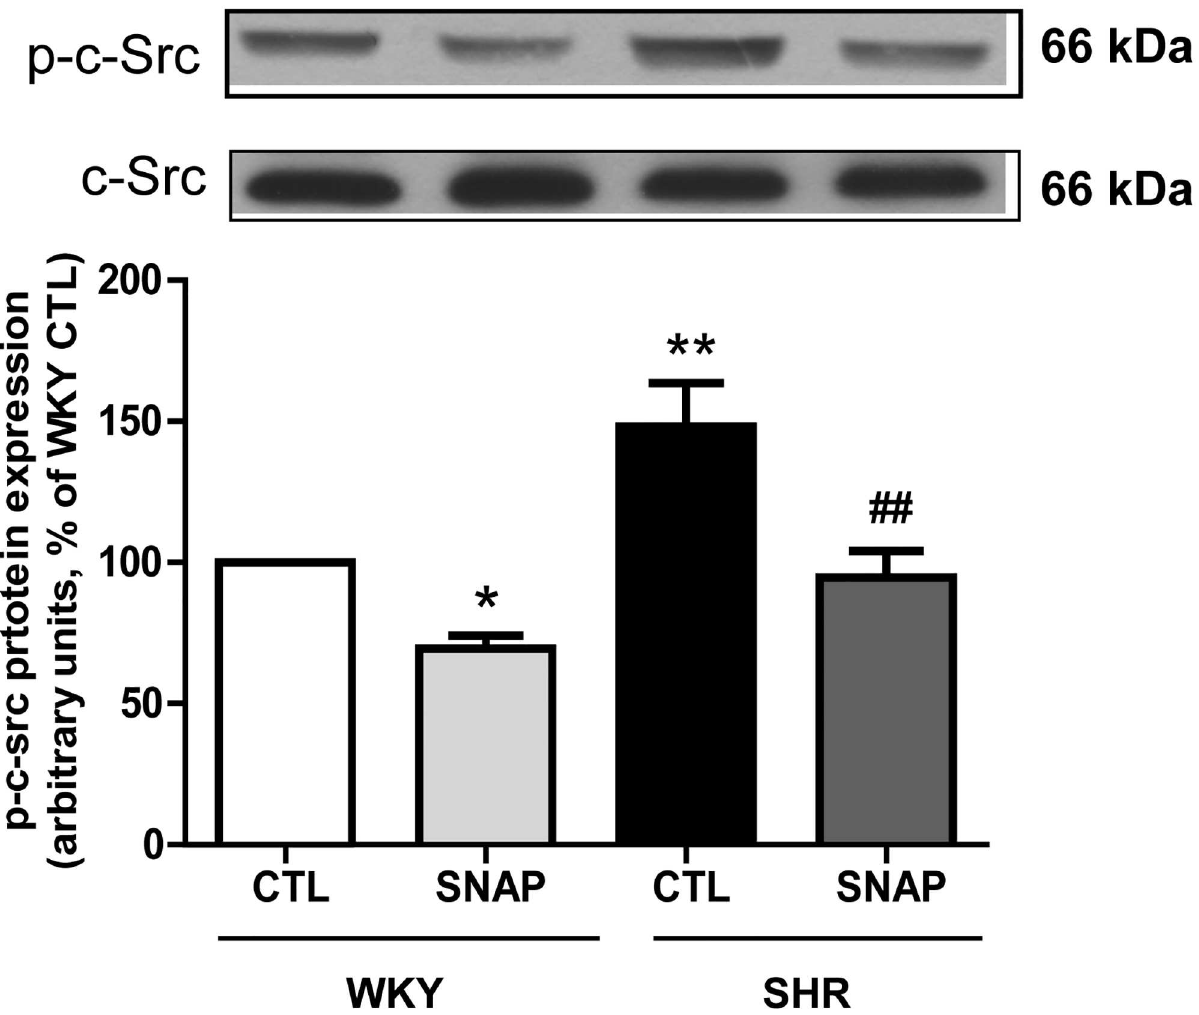
Fig 11. Effect of SNAP on expression c-Src phosphorylation in VSMC from 12-weekold SHR and age-matched WKY rats. Confluent VSMC were incubatedin the absence(control) or presence of SNAP (100 μ M) for 24 h. The cell lysates were preparedand subjectedto Western blot analysisusing specific antibodies against phosphorylated c-Src (upper panels)as describedin the Materialsand methods. Quantificationof protein bandswas done by densitometric scanning(lower panels). The results are expressedas a percentageof the WKY control (CTL), taken as 100%. Values are the mean ± SD of 4 separateexperiments using different cell populationsfrom different animals. * P < 0.05, ** P < 0.01vs WKY CTL group, ## P < 0.001vs SHR CTL